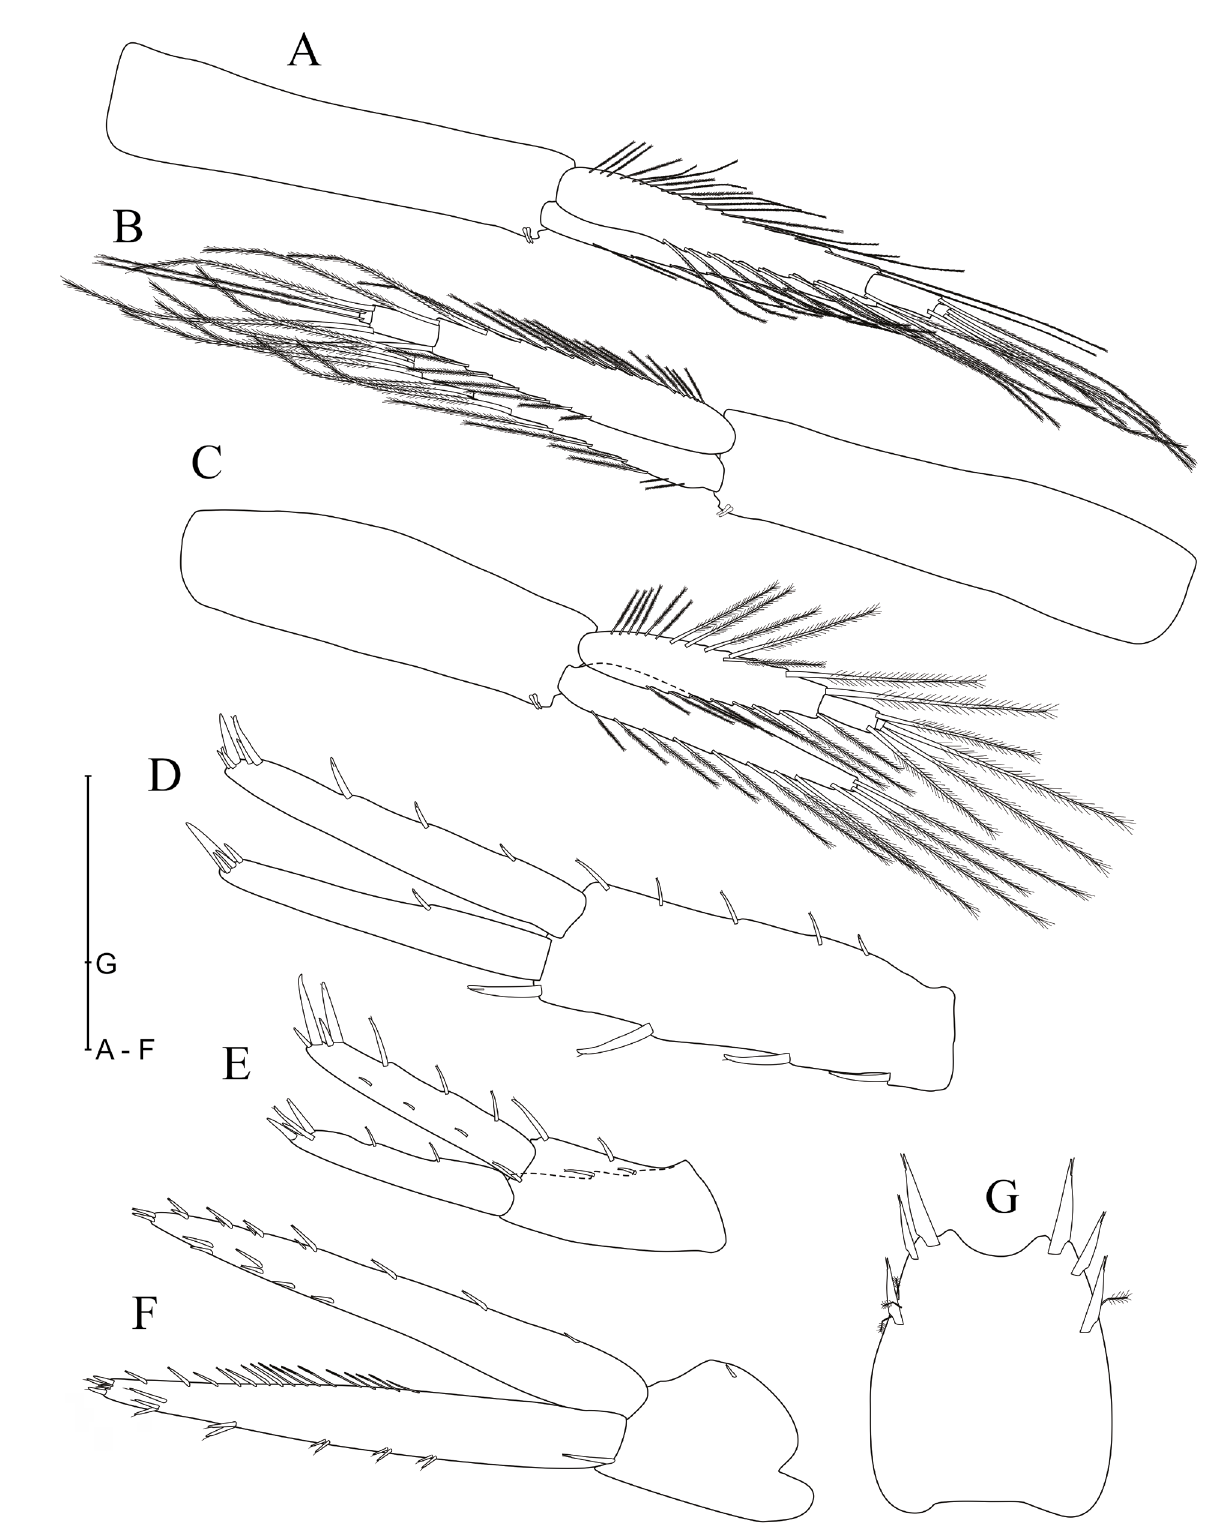
Figure 4. Spelaeogammarus ginae sp. nov., Gruna da Serra Verde cave, Serra do Ramalho, state of Bahia, Brazil. Paratype male, body length 11.31 mm; pleopod 1 ( A ); pleopod 2 ( B ); pleopod 3 ( C ); uropod 1 ( D ); uropod 2 ( E ); uropod 3 ( F ); telson ( G ). Scale bars: A–F = 1 mm; G = 200 μm. Specimens of Spelaeogammarus ginae sp. nov. were found ( C ); map indicating the state of Bahia, the Gruna da Serra Verde cave, and the land use and land cover of the area ( D ). Photographs: M.E.